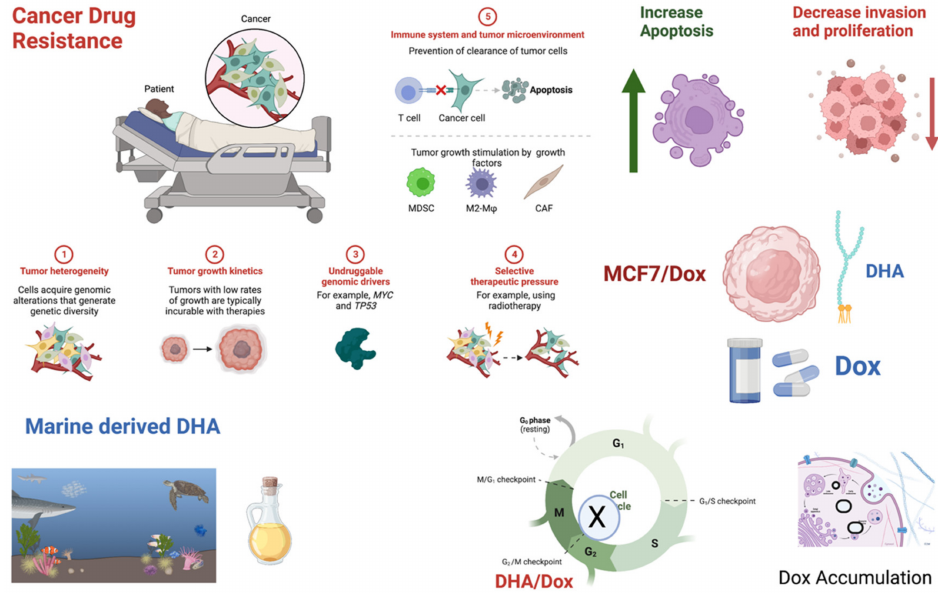
Figure 6. The effect of DHA administration on MCF-7/Dox